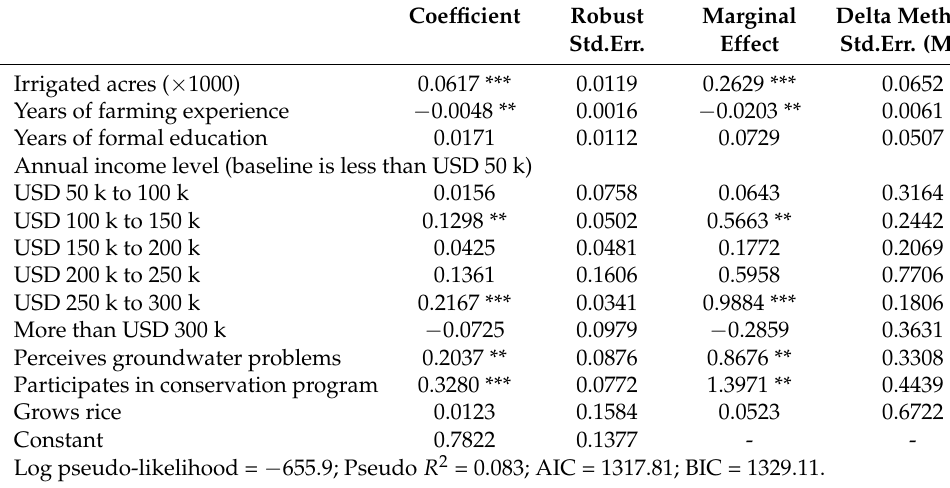
Table 12. Results from Poisson